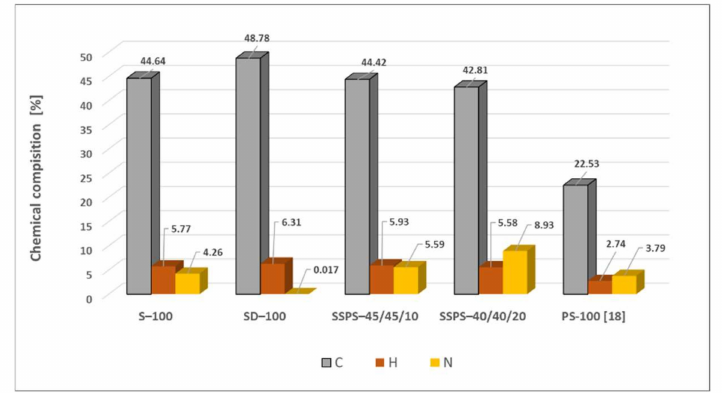
Figure 2. Ultimate analysis of pellet samples compared to paper sludge pellets (PS100).